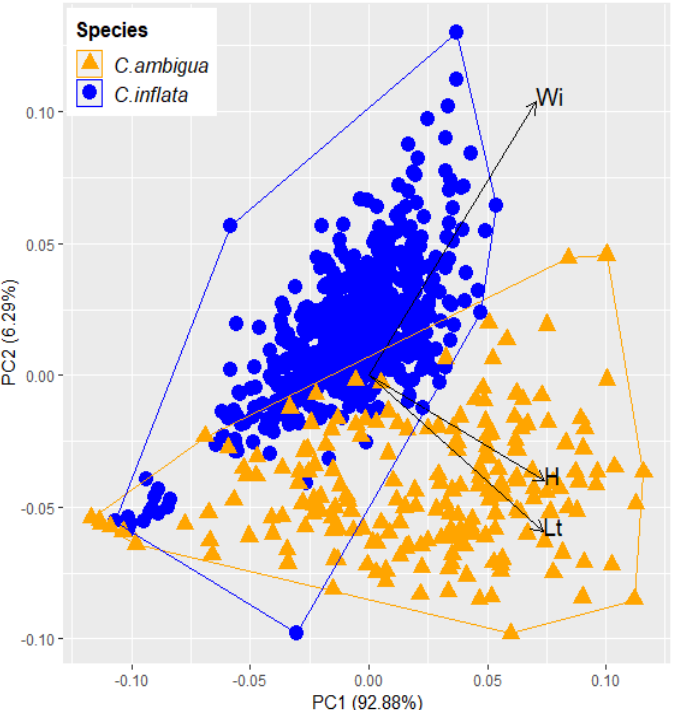
Figure 4. Ordination by principal coordinates analysis of biometrical variables of morphology designated as C. inflata (blue dots) and C. ambigua (orange dots) from the Upper Paraguay River Basin.